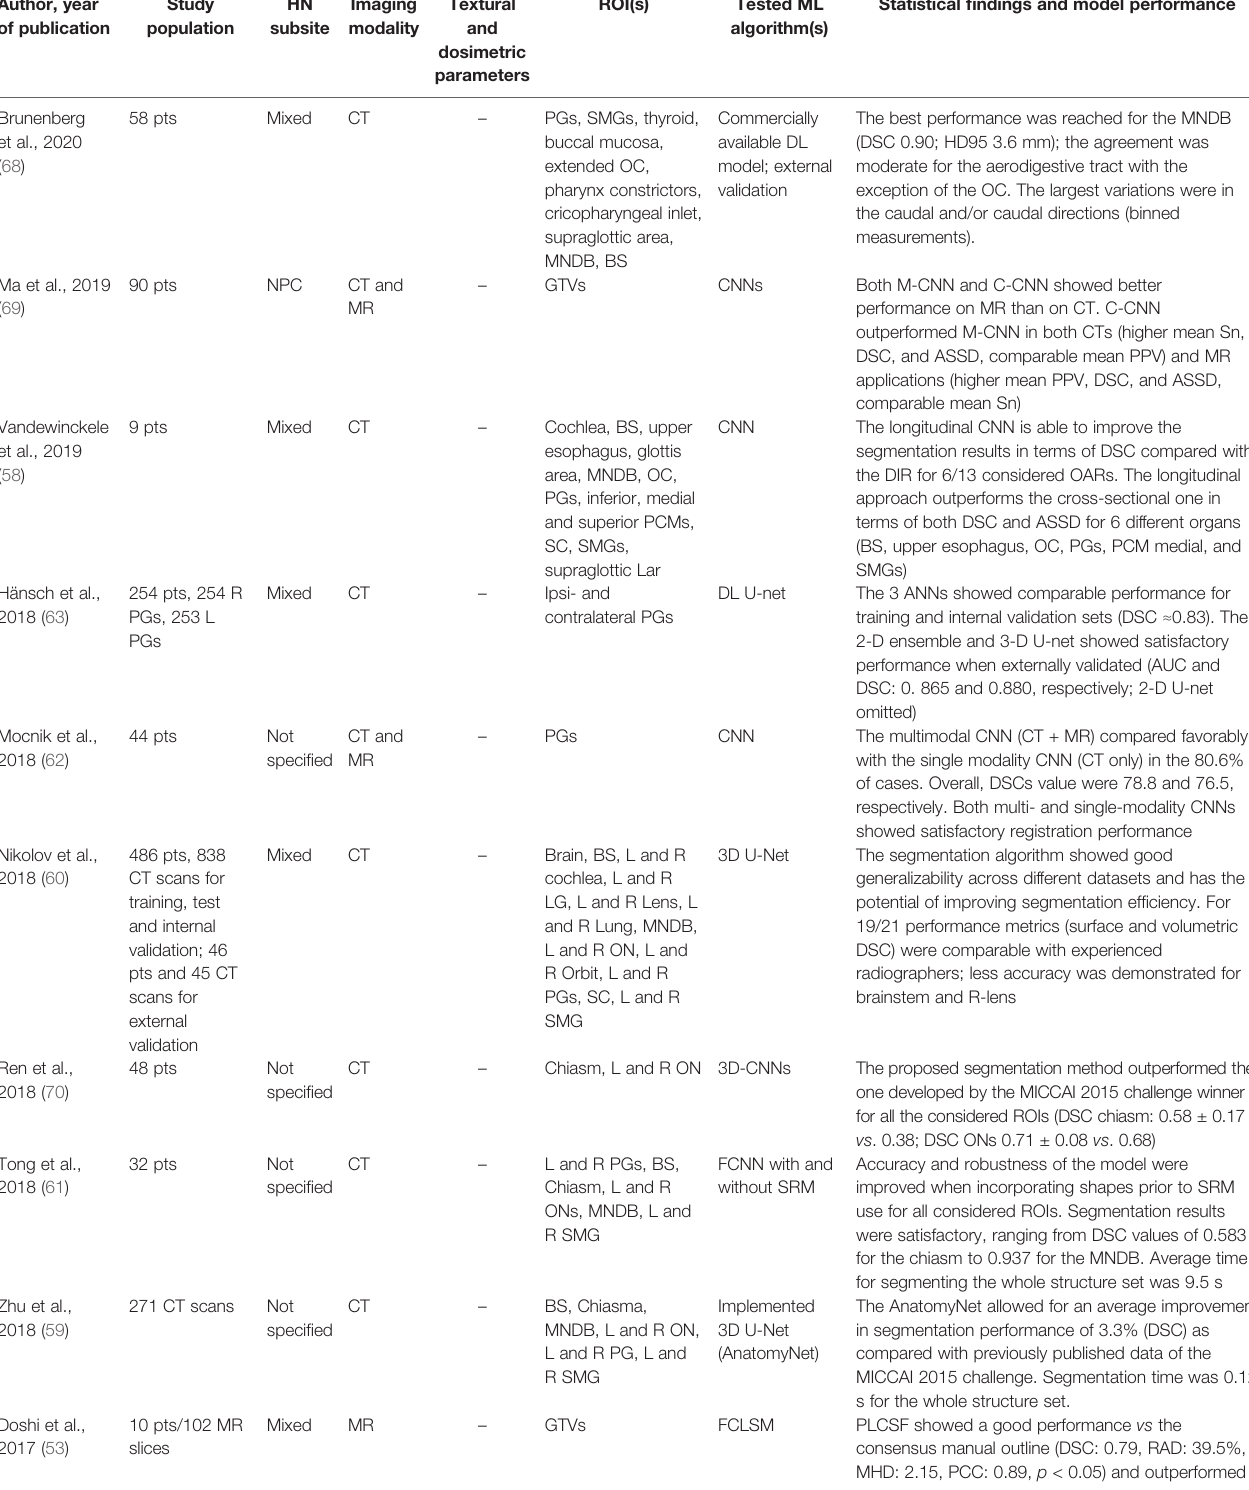
TABLE 3 | Characteristics for machine-learning studies on